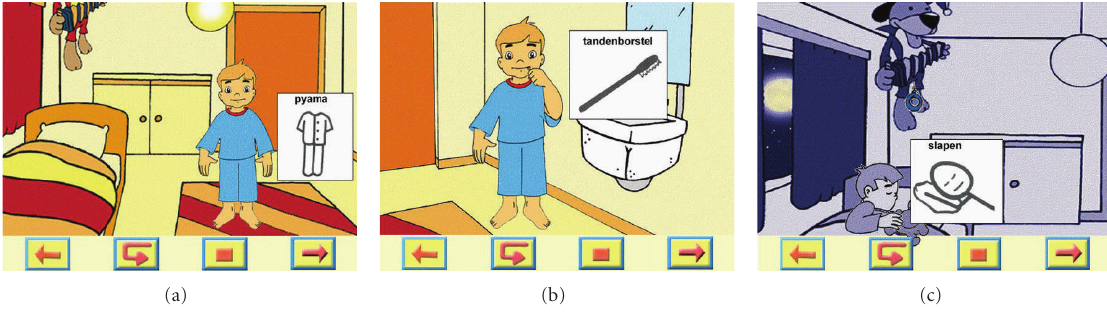
Figure 1: Screenshots from the preliminary study